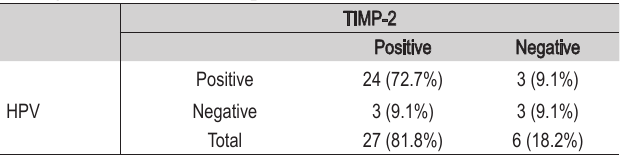
Table 1 - Expression of TIMP-2 in HPV-16 positive versus HPV- 16 negative OSCC cases (p =